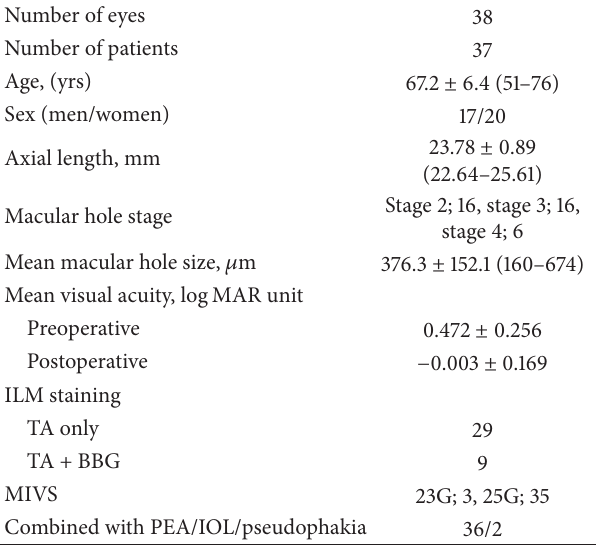
Table 1: Demographics of study